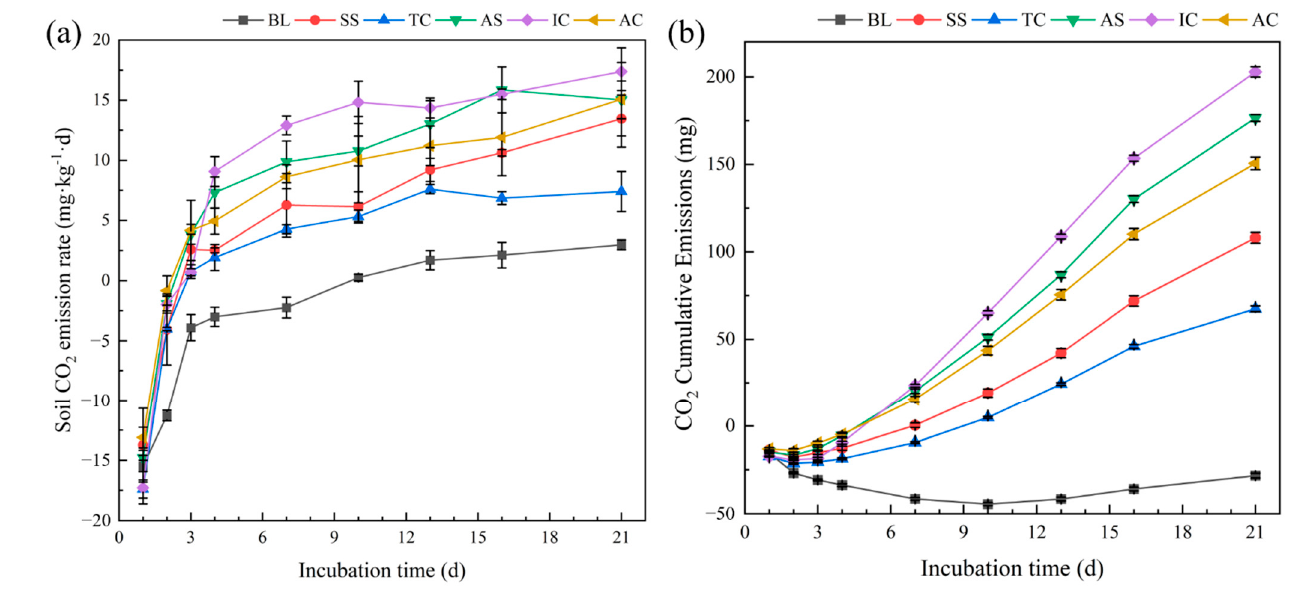
Figure 5. Variation of soil CO 2 emissions with incubation time in various plots during the succession of halophyte vegetation in the Yellow River Delta. ( a ): CO 2 emission rate; ( b ): CO 2 cumulative missions.